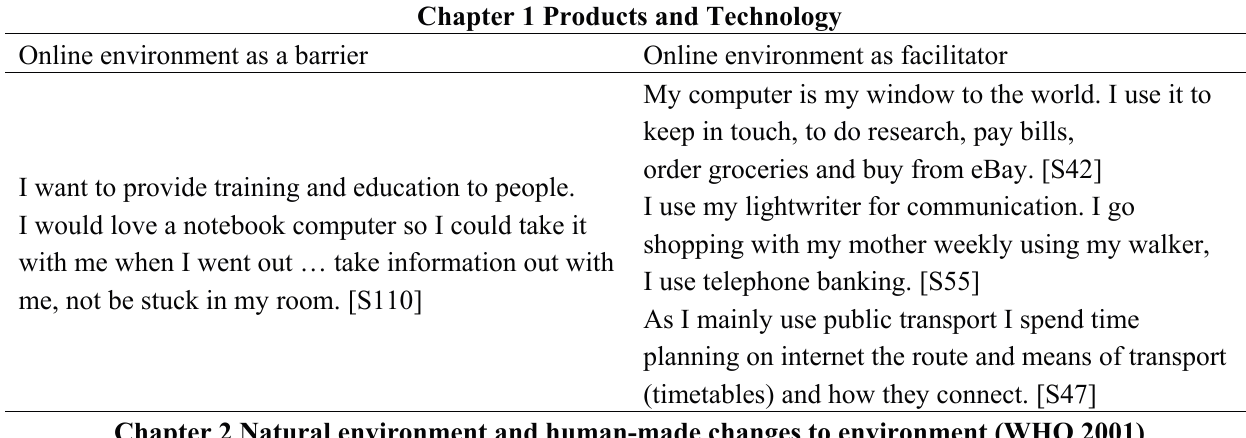
Table 3. Inclusive community environs examples by ICF